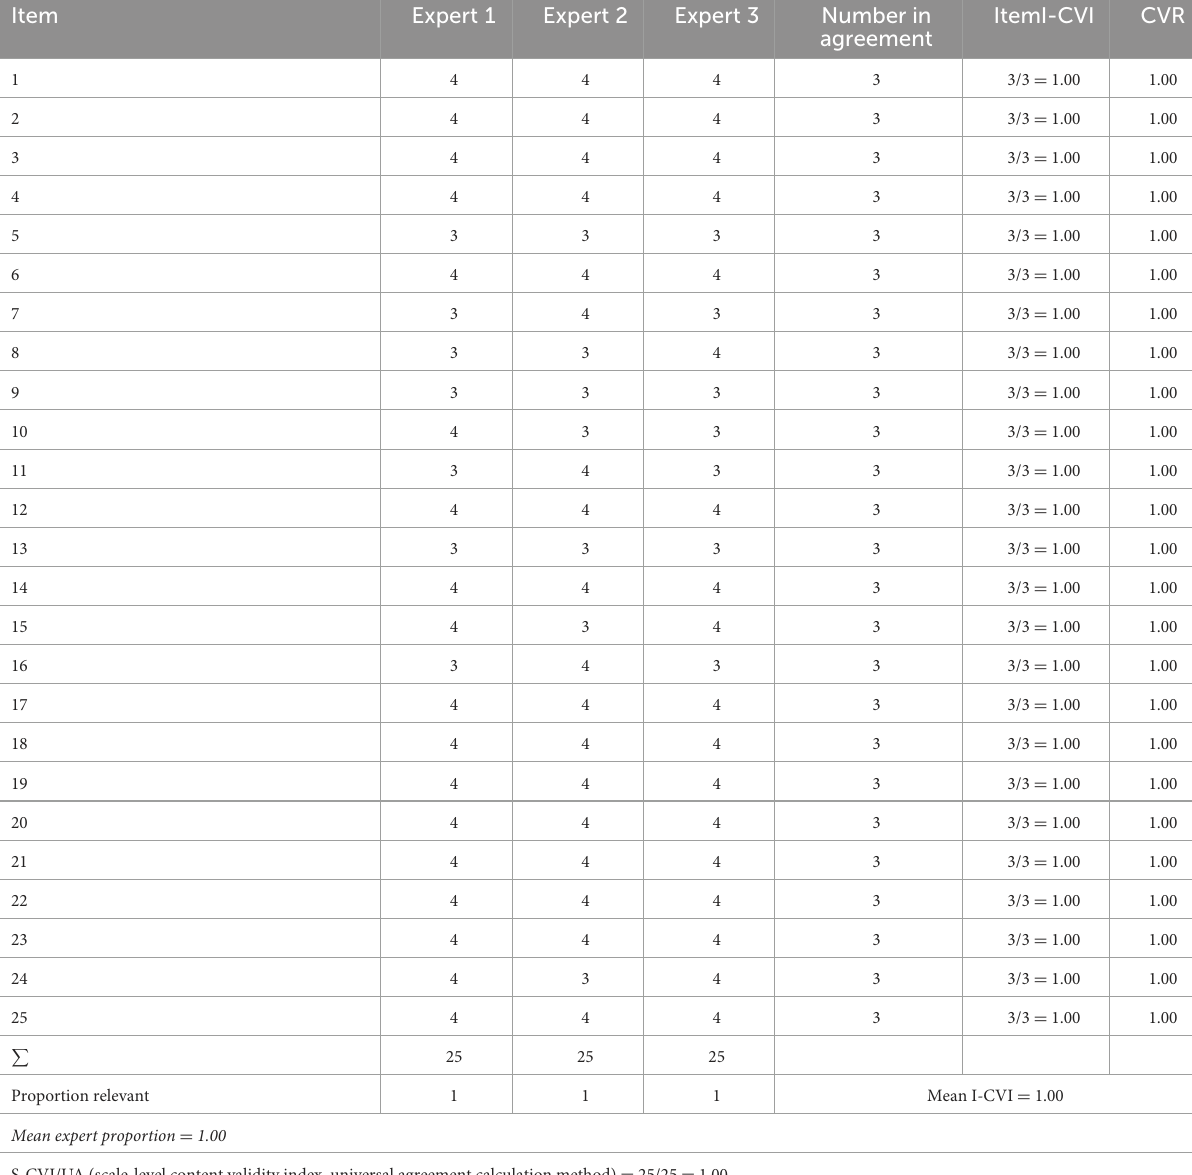
TABLE 2 Assessment of the agreement on the validity of the contents of the Indonesian version of the SANS instrument. Item Expert 1 Expert 2